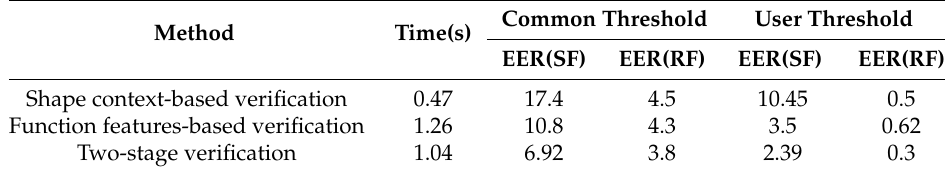
Table 5. Verification results (EER%) of different methods with common threshold and user threshold.